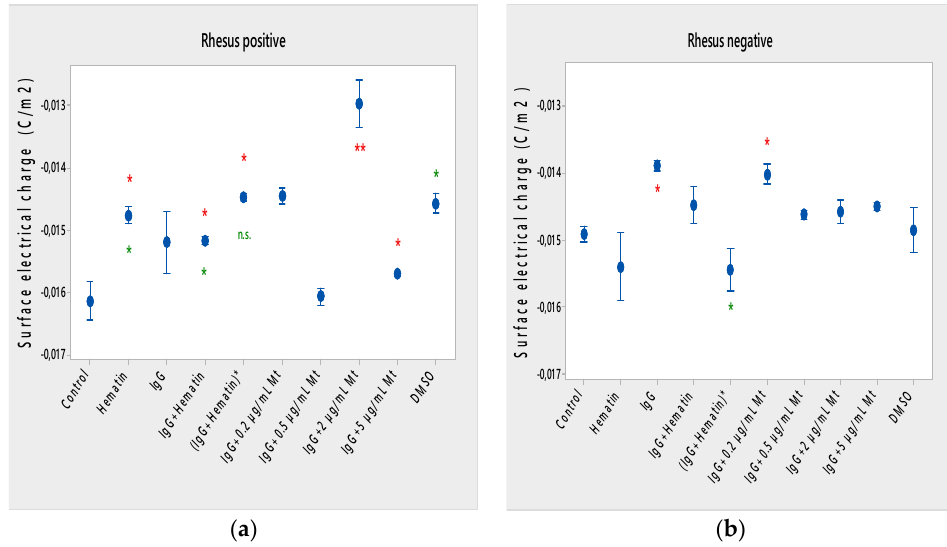
Figure 3. Zeta potential of human erythrocytes ( a ) with a Rhesus-positive factor and ( b ) Rhesus- negative factor upon fixed concentrations of pooled immunoglobulin G (10 mg/mL), hematin (80 µM) and melittin (0.2 µg/mL Mt; 0.5 µg/mL Mt; 2 µg/mL Mt and 5 µg/mL Mt) treatments. The pre- incubated sample of pooled immunoglobulin G (10 mg/mL) with hematin (80 µM) is indicated by an asterisk on the abscissa. The medium contained phosphate buffered saline (PBS), pH 7.4. Erythrocytes were treated with biomacromolecules for 1 h at 37 °C. Electrokinetic measurements were performed at 25 °C in PBS, pH 7.4. Each value is the mean ± SD of three independent preparations. * p < 0.05, compared to the untreated control (red asterisks) and compared to DMSO (80 µM)-treated control (green asterisks).